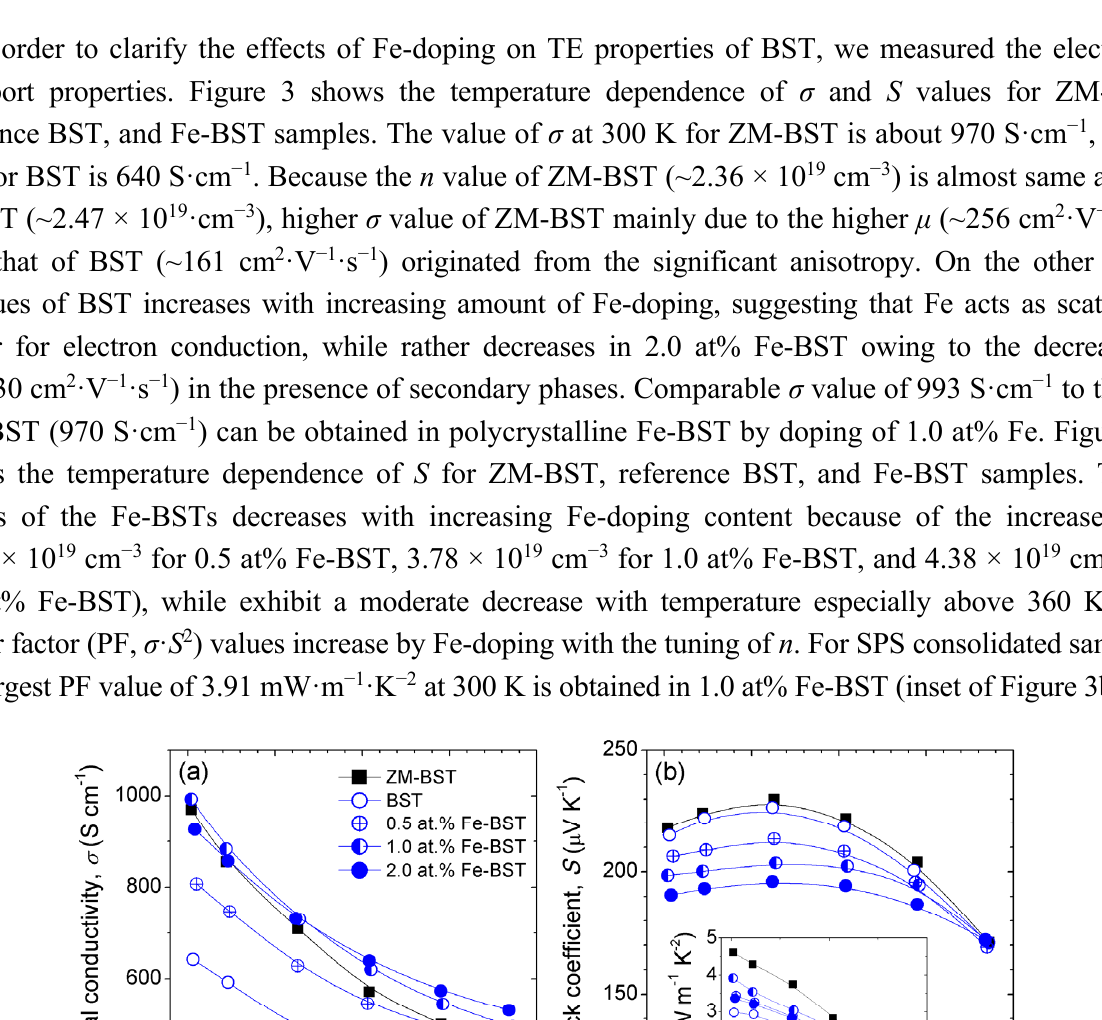
Figure 2. SEM images of fractured surface of ( a ) BST and ( b ) 2.0 at% Fe-BST samples.